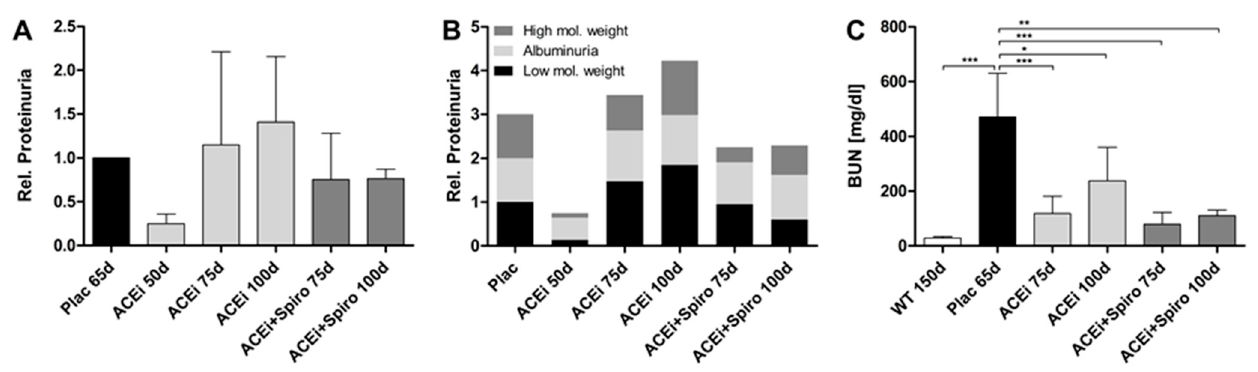
Figure 2. Effect on protein excretion and kidney function on days 50, 75 and 100 of therapy with ACEi and ACEi+Spiro. ( A ) Total renal protein excretion (relative to untreated mice at 65 days) in the ACEi group compared to the ACEi+Spiro group ( n = 3 for each group); ( B ) Relative change in excretion of high molecular weight proteins (glomerular damage), albumin and low molecular weight proteins (tubular damage) in the ACEi group compared to the ACEi+Spiro group ( n = 3 for each group); ( C ) Blood urea nitrogen (BUN) levels in the untreated mice compared to the ACEi group and the ACEi+Spiro group ( n = 3 for WT and ACEi 100d, n = 4 for Plac, ACEi 75d and ACEi+Spiro 75d, n = 2 for ACEi+Spiro 100d); *** p < 0.001; ** p < 0.01; * p < 0.05.